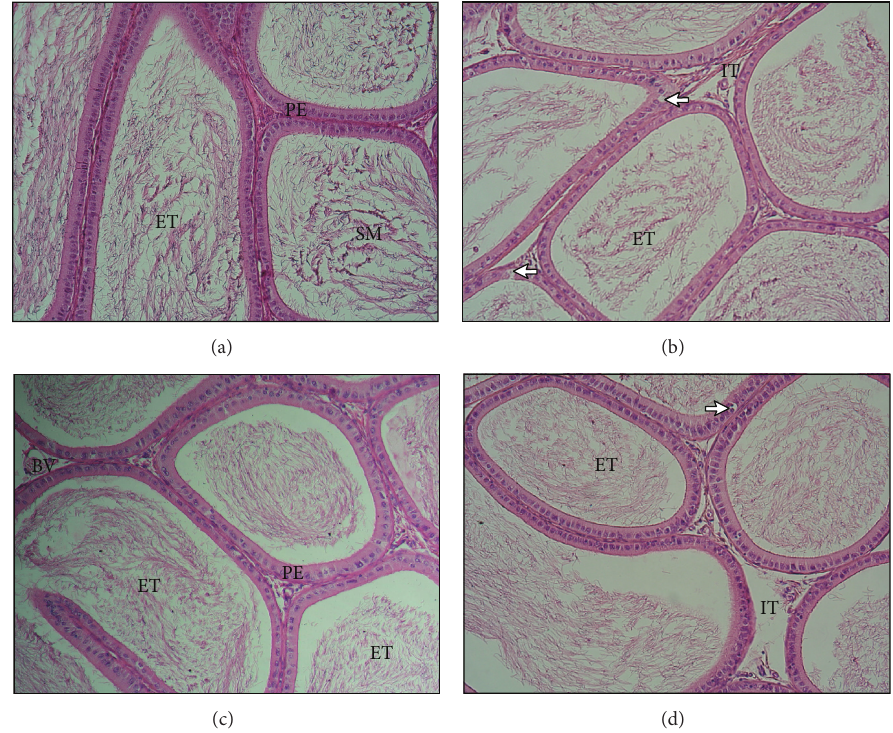
Figure 2: Photomicrographs showing histology of epididymal tissue from control group (a), group exposed to cadmium at a dose of 30 mg/L (b), group exposed to diazinon at a dose of 40mg/L (c), and group exposed to cadmium at a dose of 30 mg/L and diazinon at a dose of 40 mg/L (d). ET: epididymal tubules, PE: pseudostratified columnar epithelium, IT: interstitial tissue, SM: spermatozoa, BV: blood vessels, CD: cellular debris, and arrows: intraepithelial empty spaces (hematoxylin-eosin, original magnification ×